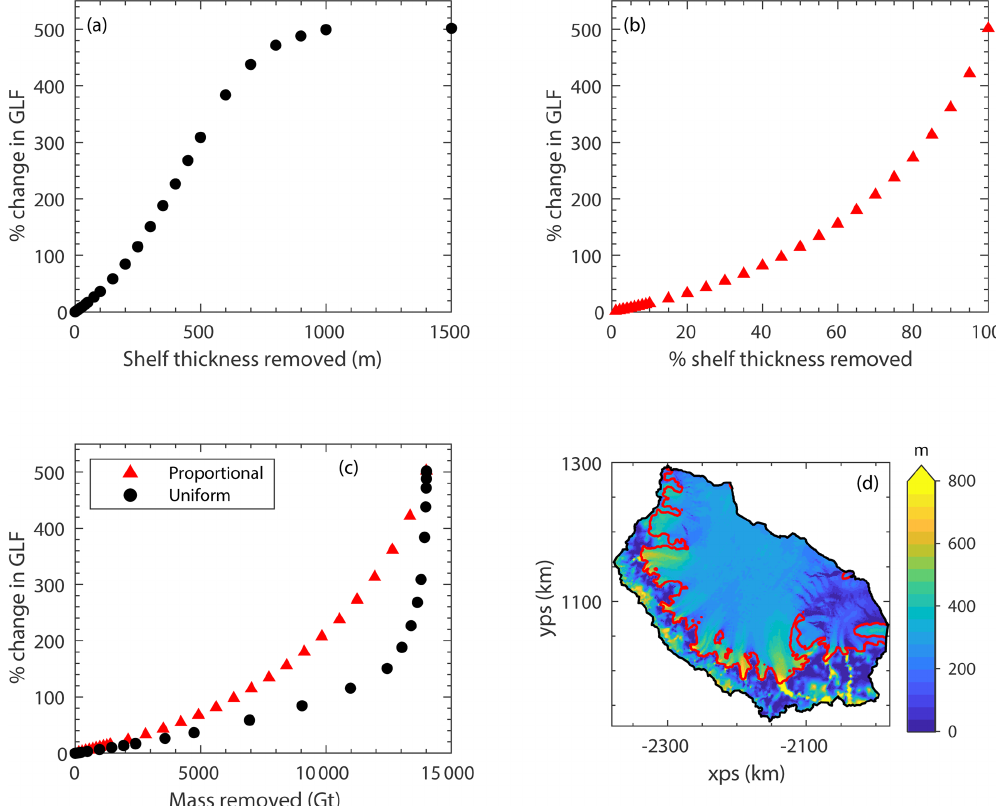
Figure 6. Panel (a) is the percentage change in grounding line flux during the “uniform” thinning experiments, and (b) is the same but for the “proportional” thinning experiments. Panel (c) is the response in grounding line flux for the two sets of experiments, but with the perturbations expressed in the amount of mass removed rather than the amount of thinning applied. Panel (d) shows a map of ice thickness across the model domain from BedMachine Antarctica v2 (Morlighem et al., 2020), with grounding lines plotted in